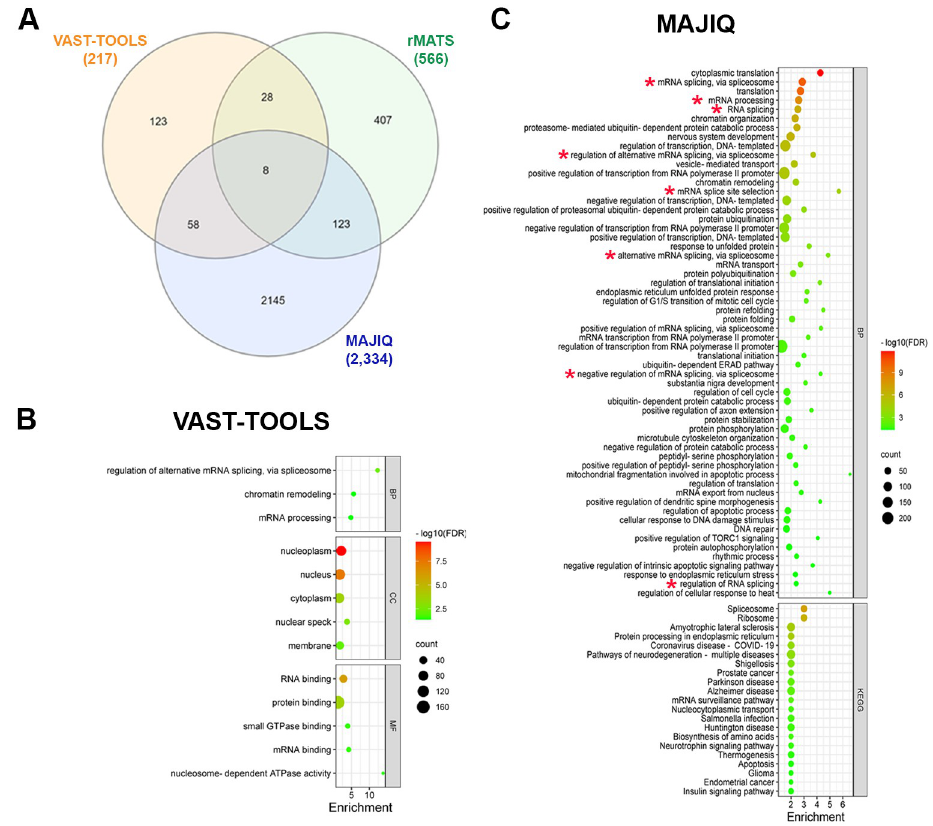
Fig 2. Analysis of alternative splicing events predicted to be altered by ethanol in the human embryonic cortical tissue dataset. A) Venn diagram showing the number of genes predicted to undergo altered alternative splicing events due to ethanol exposure, using VAST-TOOLS, rMATS, and MAJIQ. B, C) Gene Ontology analysis of genes predicted to contain alternative splicing events altered by ethanol exposure, using VAST-TOOLS (B) and MAJIQ (C) . BP, Biological Process, CC, Cellular Component, MF, Molecular Function, KEGG, Kyoto Encyclopedia of Genes and Genomes, FDR, False Discovery Rate.